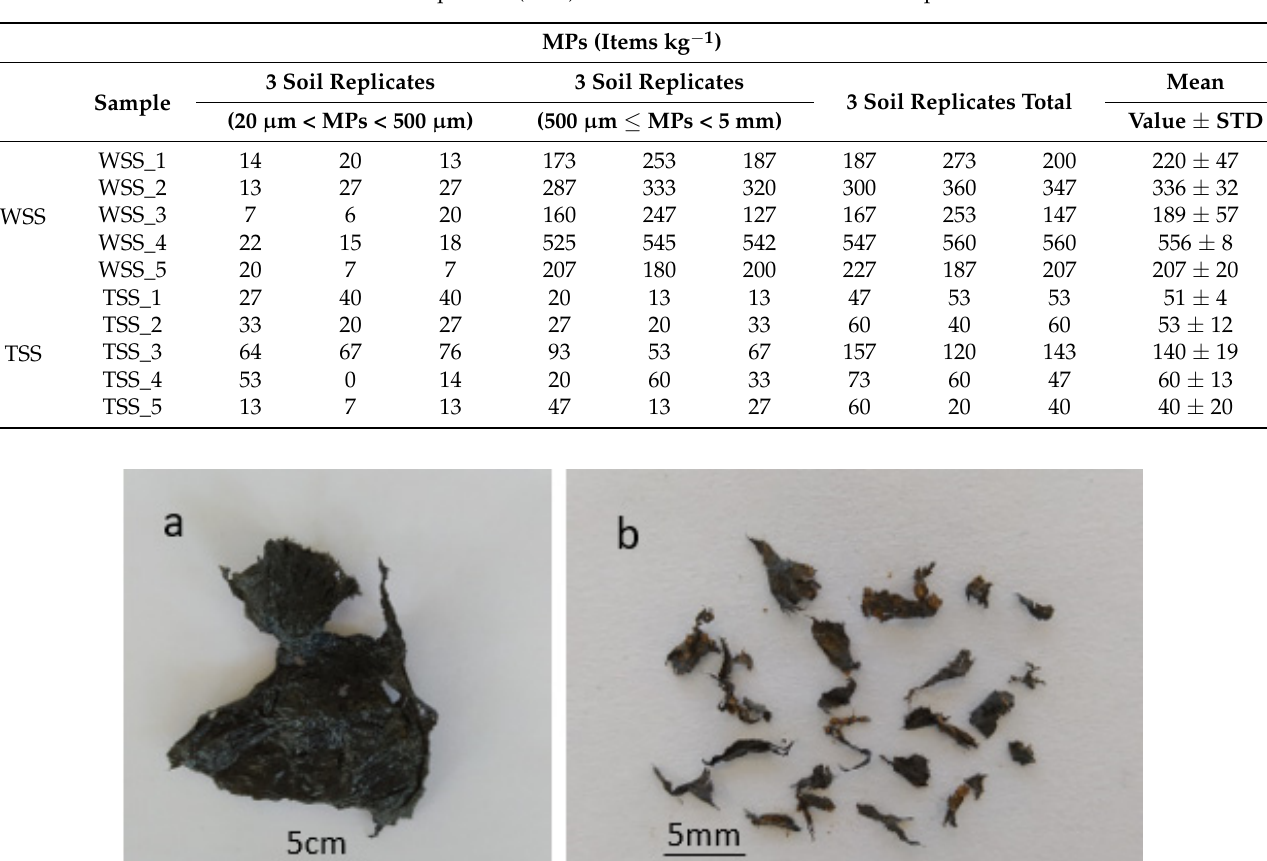
Table 1. Microplastics (MPs) abundance in cultivations soil samples.